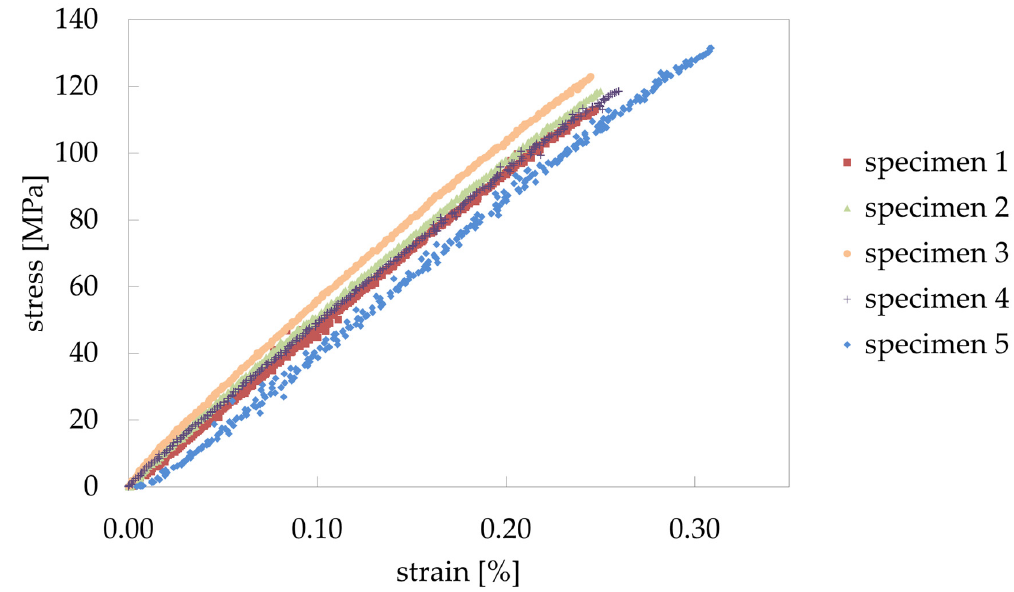
Figure 8. Stress-strain diagram of the tested samples. For specimen 1 and 2 all values incl. the unloading curves are shown. Table 2. Mechanical properties of the five tested specimen. R m *—ultimate tensile strength;